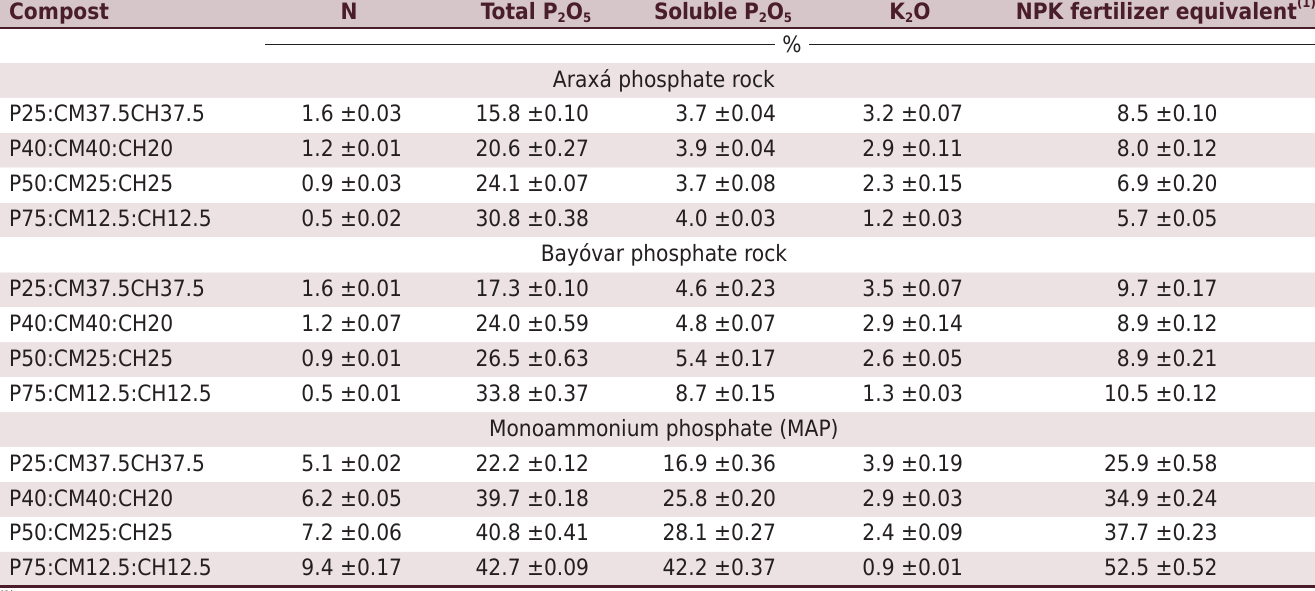
Table 4. Total N, P 2 O 5 , and K 2 O contents, contents of citric acid-soluble P 2 O 5 for mixtures with phosphate rocks, and neutral ammonium citrate plus water-soluble (NAC+H 2 O) P 2 O 5 for mixtures with monoammonium phosphate, and NPK fertilizer equivalent, followed by standard error, after 150 days of composting